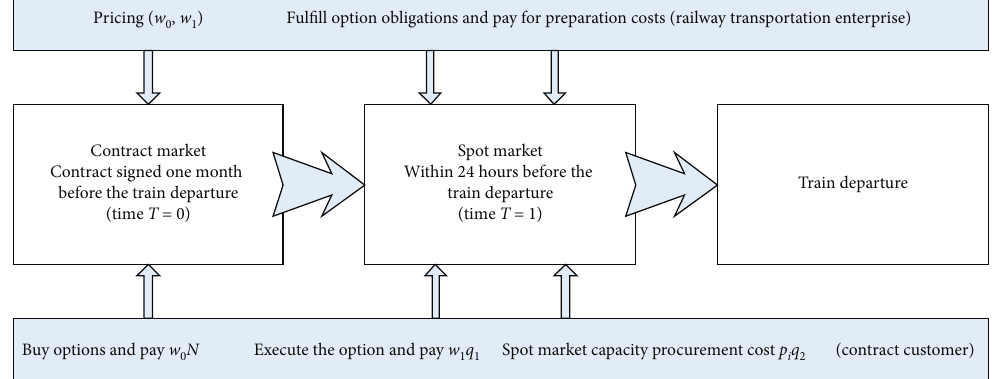
Figure 2: The transaction process of